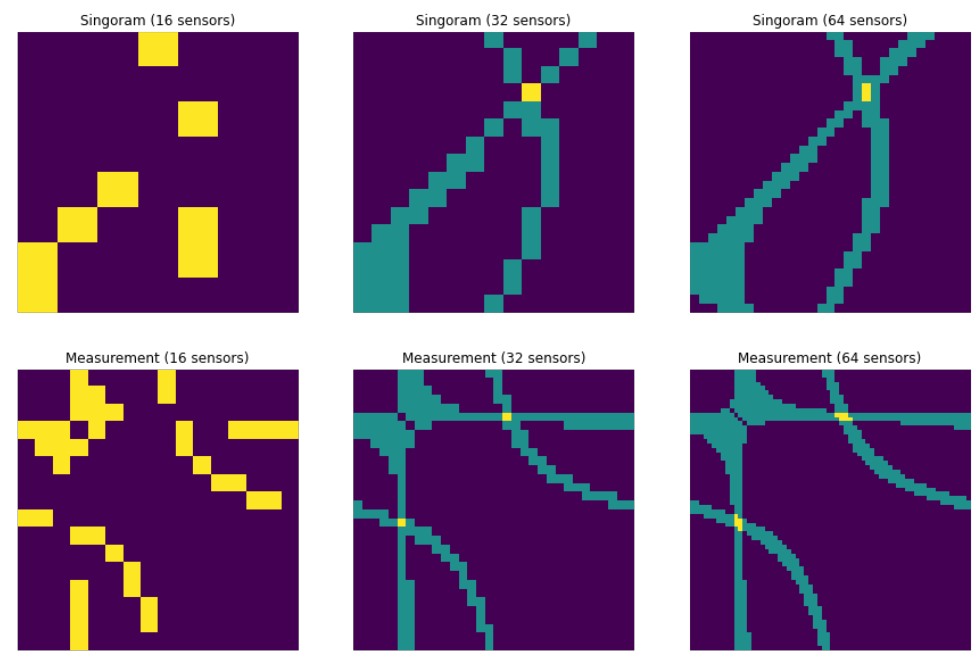
Figure 1. The sinograms (top row) calculated from the measurements (bottom row) for the case of 16, 32, and 64